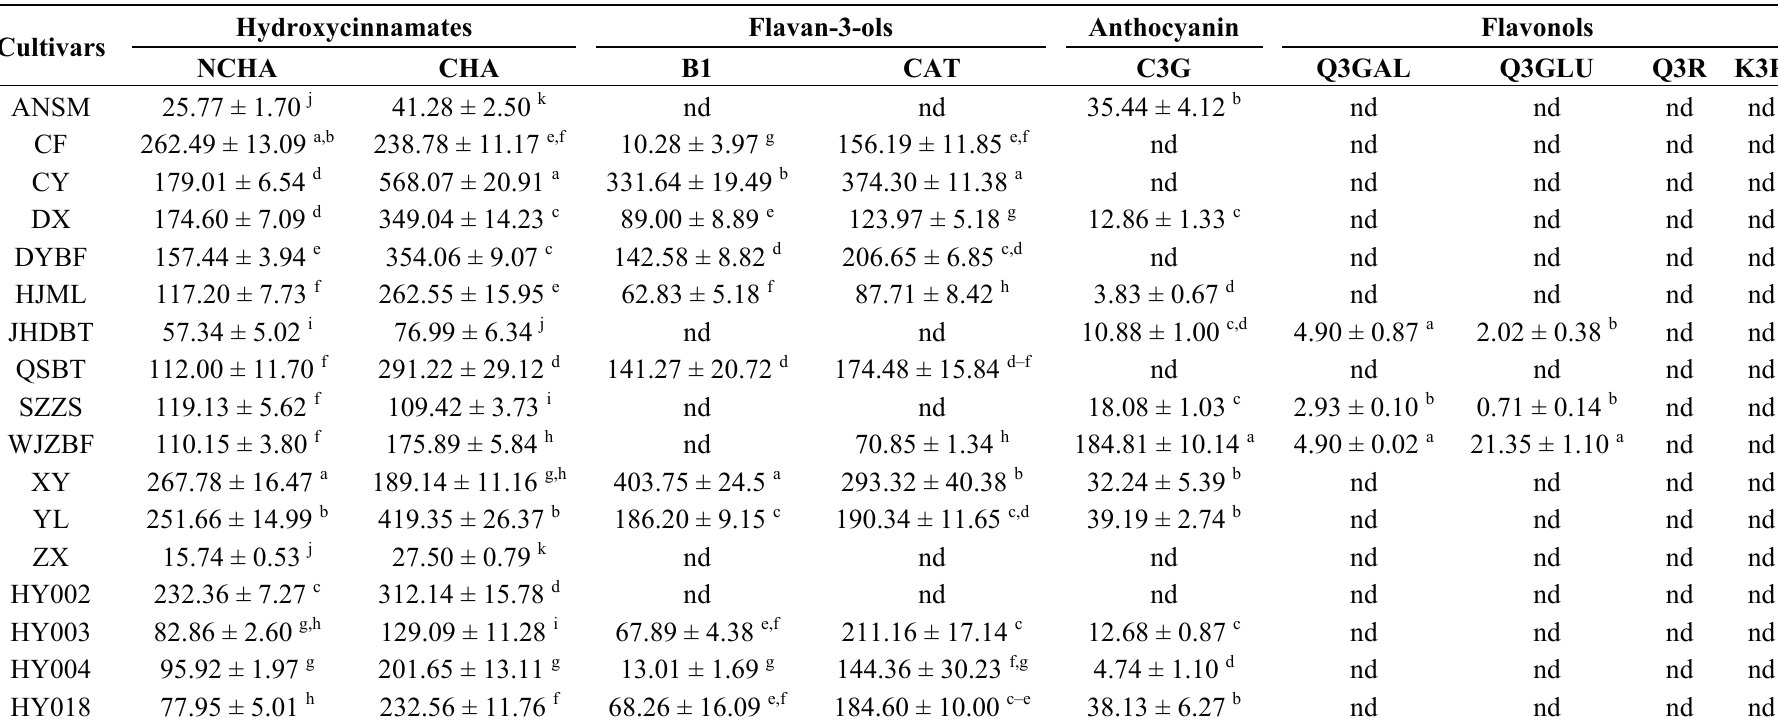
Table 4. Contents of the nine phenolic compounds (mg/kg DW) detected in the pulp tissues of 17 P. persica